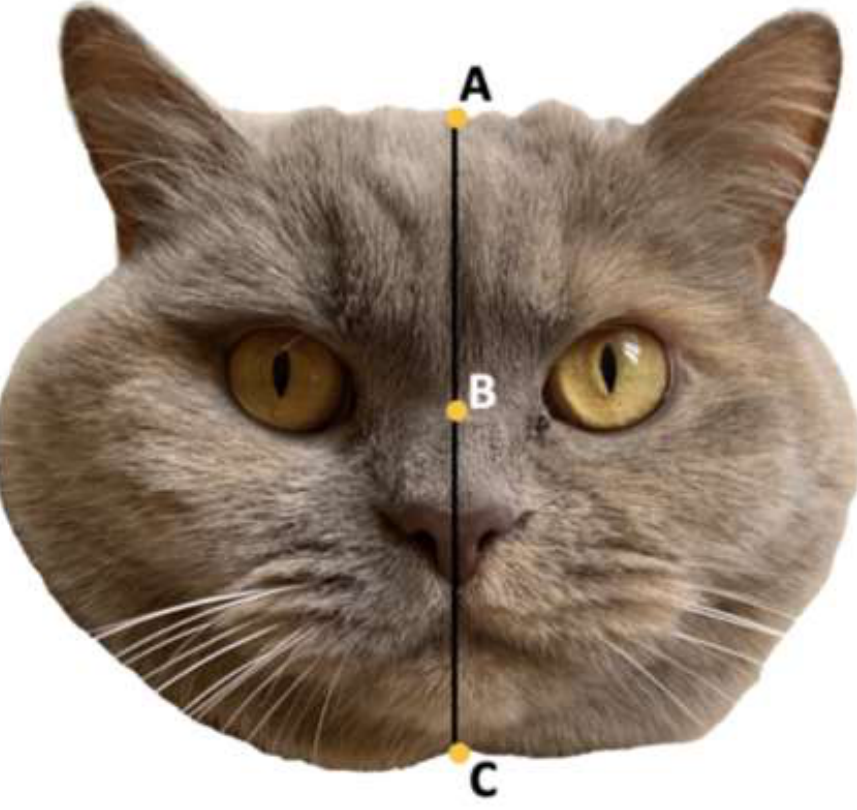
Figure 2. Archer and Monton (2011) Facial Index Score. Forehead length (AB) divided by middle of eyes to the chin (BC).